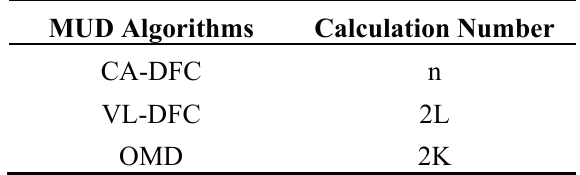
Table 2. The computational complexity